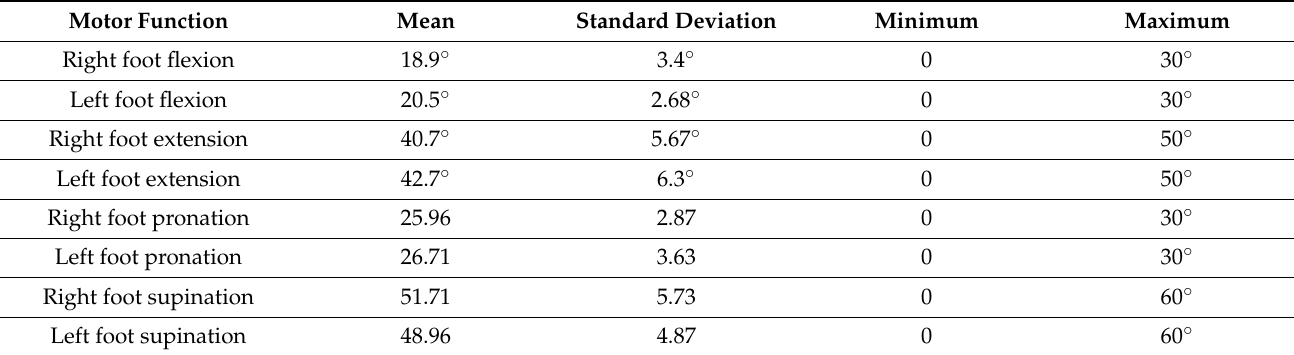
Figure 2. The motor functions of the foot ( a – c ). Table 1. The statistics of the motor function of left and right feet data.